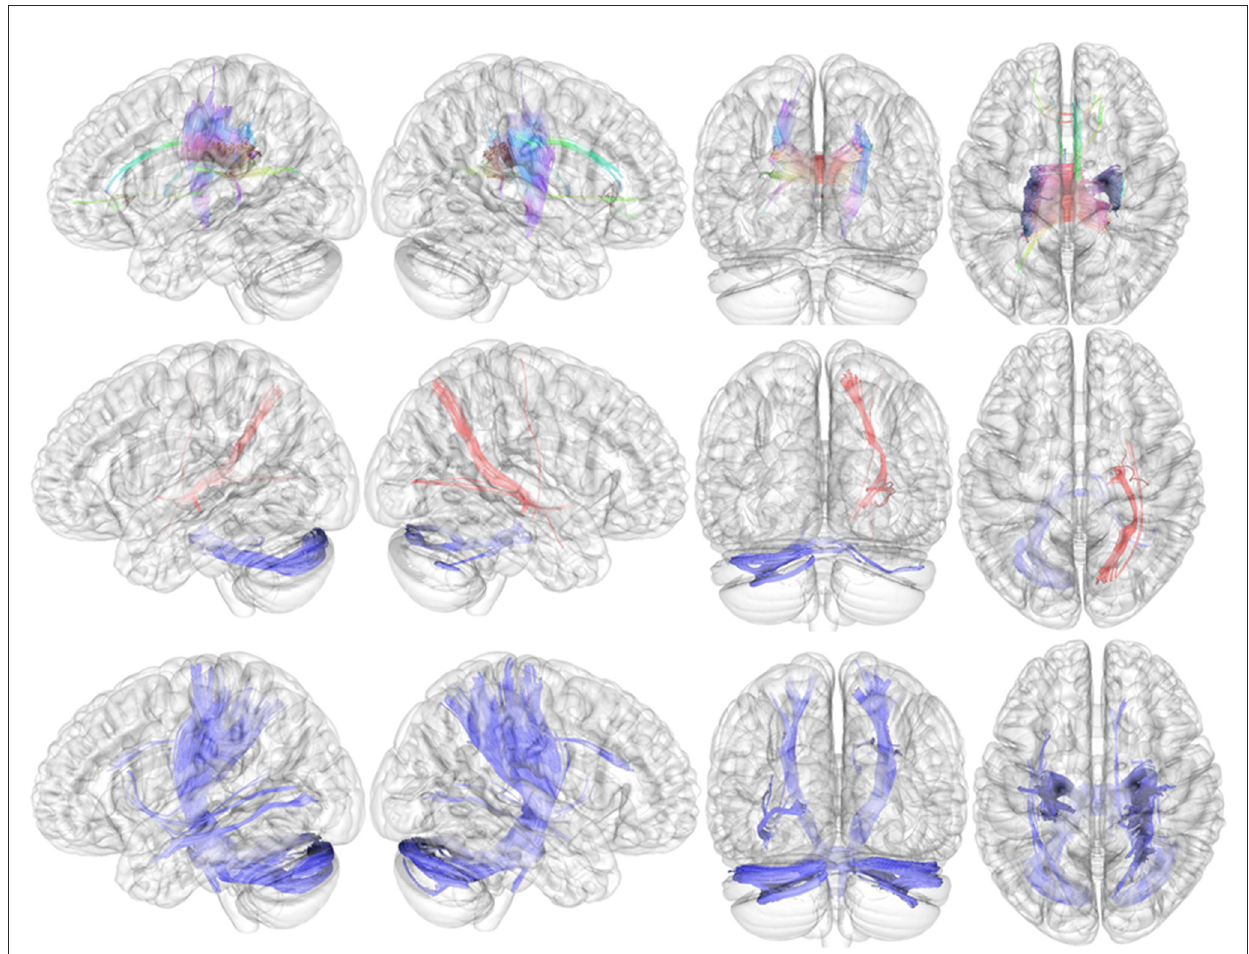
FIGURE2 Results of local connectometry. Upper: Compared with HCs, the connectometry analysis identified significantly decreased connectivity in patients with adult ADHD in the body of the corpus callosum, the cingulum bundle, the forceps minor, the forceps major, the left fornix, the right corticospinal tract, the right superior longitudinal fasciculus III, the right medial lemniscus, and the right corticopontine tract. Middle: Significantly positive correlations between QA and severity of hyperactive–impulsive symptoms in the right corticostriatal tract, the right corticopontine tract, the right corticospinal tract, the right inferior fronto-occipital fasciculus, and the right extreme capsule (red fibers). The QA in the middle cerebellar peduncle and the left cerebellum was found to be negatively related to the severity of hyperactive–impulsive symptoms (blue fibers). Bottom: The connectometry analysis found negative correlations between QA and severity of inattentive symptoms in the bilateral corticospinal tract, the left inferior longitudinal fasciculus, the right corticopontine tract, the middle cerebellar peduncle, the bilateral cerebellum, the right medial lemniscus, and the right dentatorubrothalamic